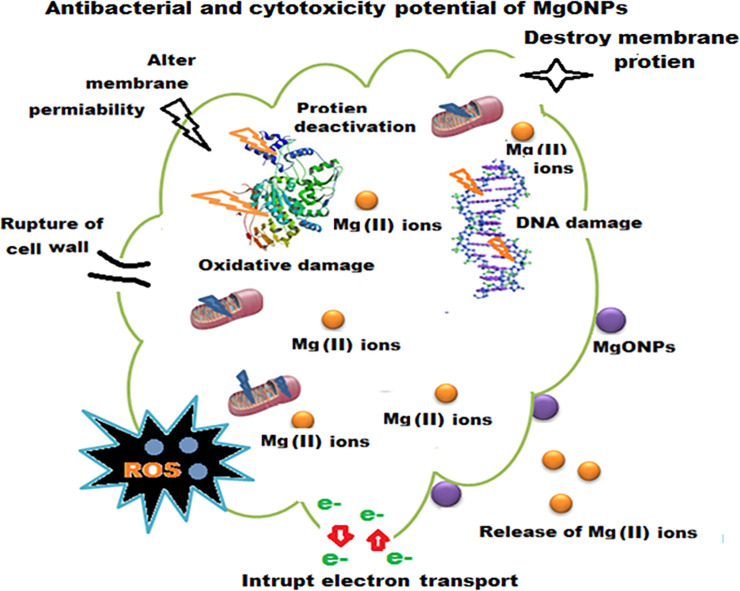
Schematic diagram of the mechanism of antibacterial and cytotoxicity potential of MgONPs.